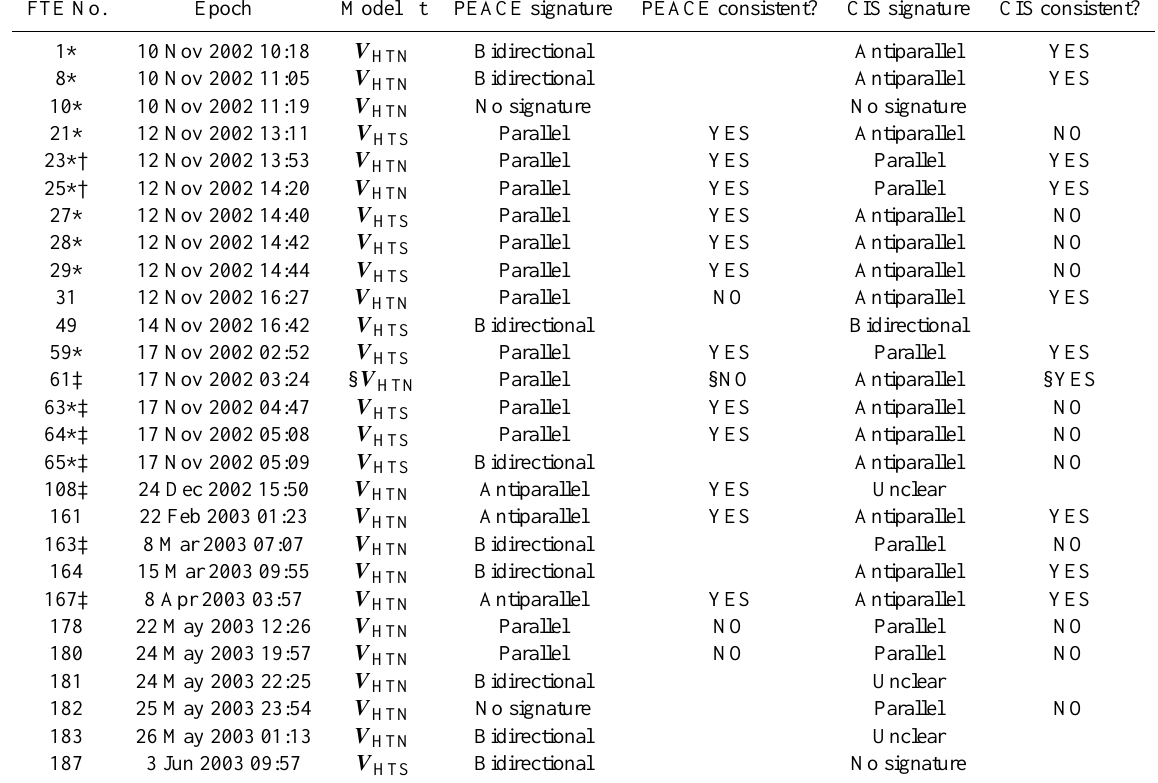
Table 1. A list of the plasma signatures observed for events which were consistent in angle with only one Cooling model velocity. “Epoch” refers to the time of observation of the FTE. “Model fit” shows which of the two Cooling model de Hoffmann-Teller velocities was consistent with the observed FTE velocity. “PEACE signature” and “CIS signature” shows whether a unidirectional electron or ion signature was observed by at least one spacecraft, and whether the signature is in pitch angles parallel or antiparallel to the magnetic field. Bidirectional electron or ion signatures are also noted if no unidirectional signature was observed. It is noted whether the signature is consistent with the hemisphere of connection of the model de Hoffmann-Teller velocity from the Cooling model, bearing in mind whether the FTE was observed inside or outside the magnetopause. Where the Cluster tetrahedron straddled the magnetopause, the magnetosheath signatures are given in this table, as this reduces the ambiguity introduced in magnetospheric signatures by ions and electrons mirroring at low altitudes. FTE No. Epoch Model fit PEACE signature PEACE consistent? CIS signature CIS